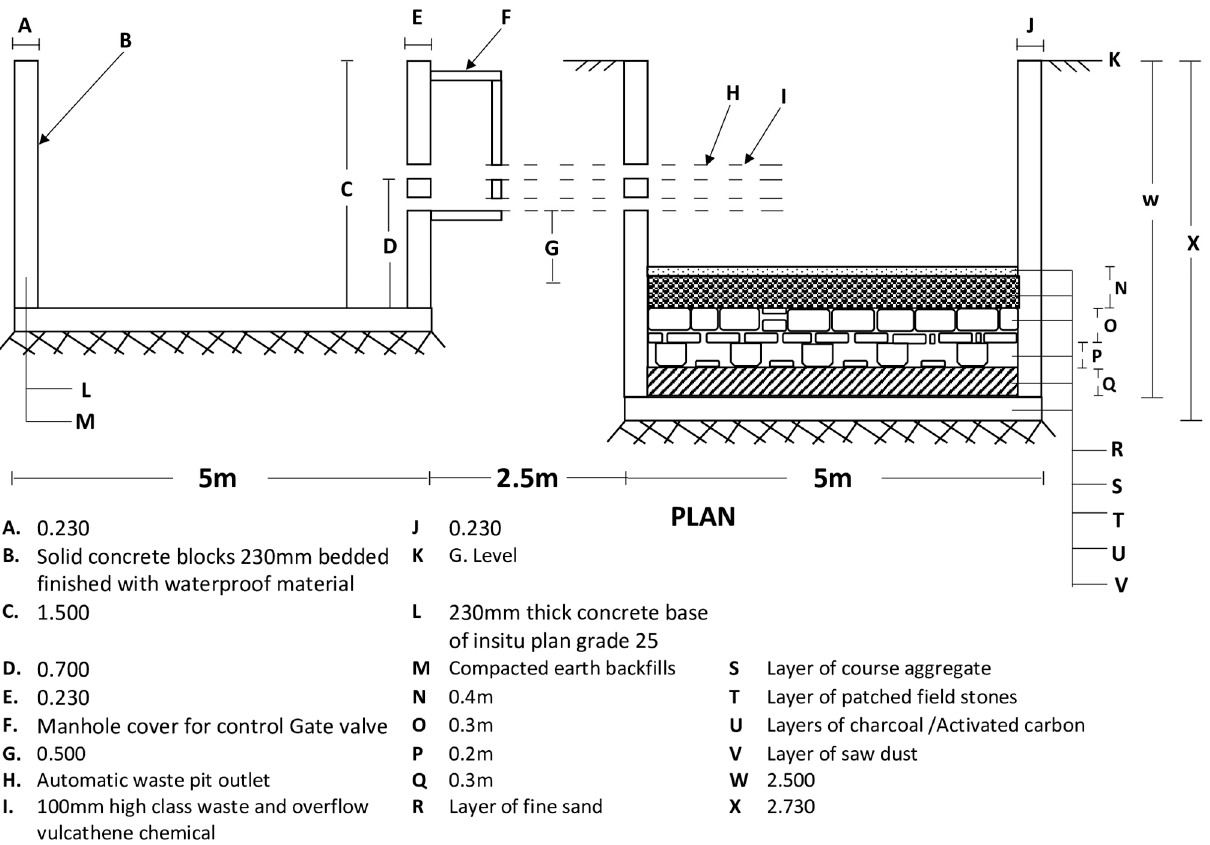
Figure 4. Hazardous waste pit schematic blueprint provided by NEMC. A, C, D, E, G, and J are measurements in meters.